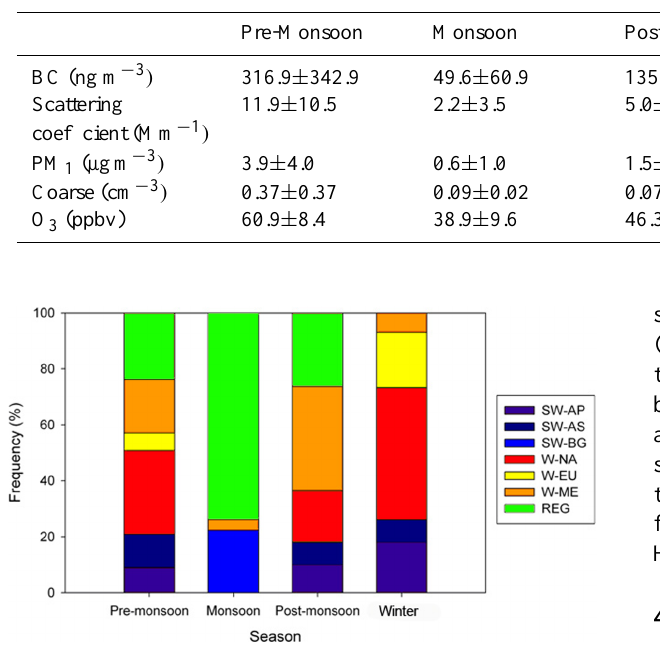
Fig. 6. Seasonal cluster frequencies at NCO-P for the period March 2006–February 2008: SW-AP (South Westerly-Arabian Peninsula), SW-AS (South Westerly-Arabian Sea), SW-BG (South Westerly-Bengal Gulf), W-NA (Westerly-North Africa), W-EU (Westerly-Europe), W-ME (Westerly-Middle East), REG (Re-